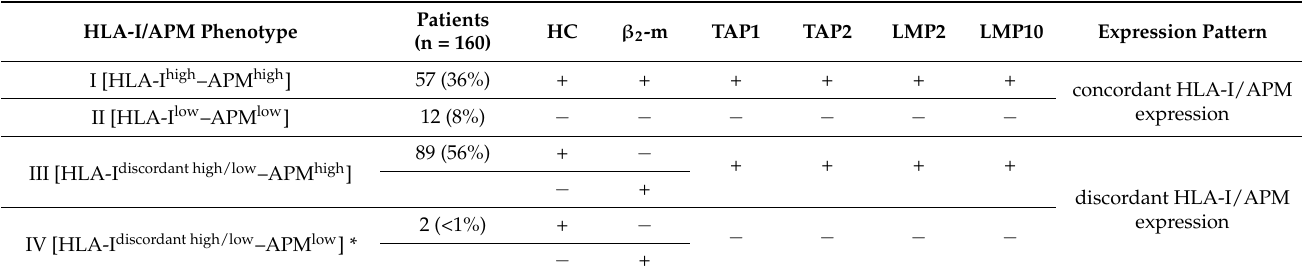
Table 3. Classification of OSCC Lesions According to the HLA-I/APM Expression.